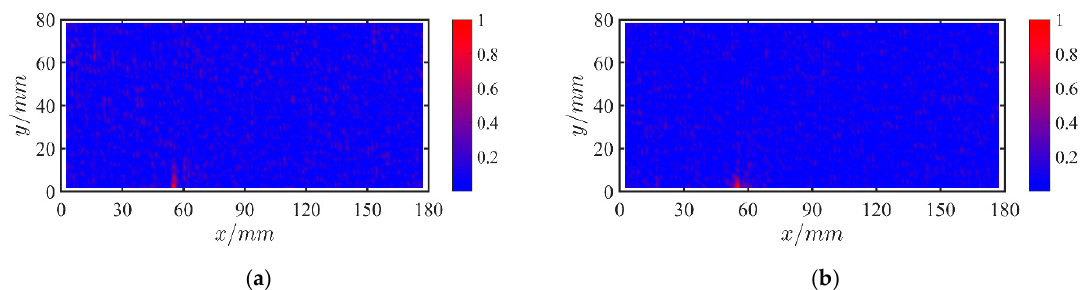
Figure 13. The RDIs colored plot of the torsion modes in the y direction for a slight crack plate. ( a ) RDIs of the first torsion mode of 233.43 Hz. ( b ) RDIs of the second torsion mode of 750.94 Hz.